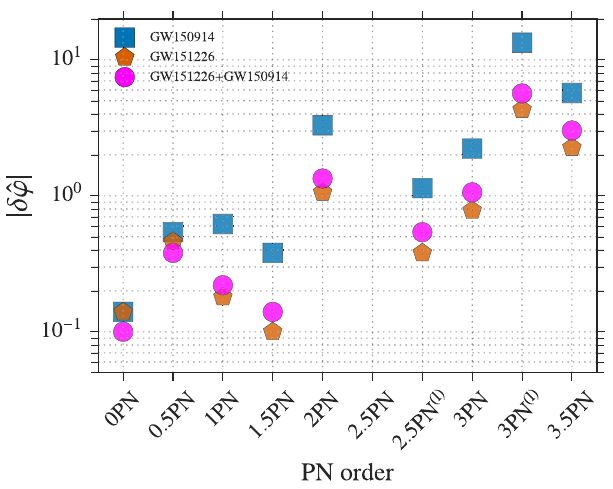
FIG. 8. The 90% credible upper bounds on deviations in the PN coefficients, from GW150914 and GW151226. Also shown are joint upper bounds from the two detections; the main contributor is GW151226, which had many more inspiral cycles in band than GW150914. At 1PN order and higher, the joint bounds are slightly looser than the ones from GW151226 alone; this is due to the large offsets in the posteriors for